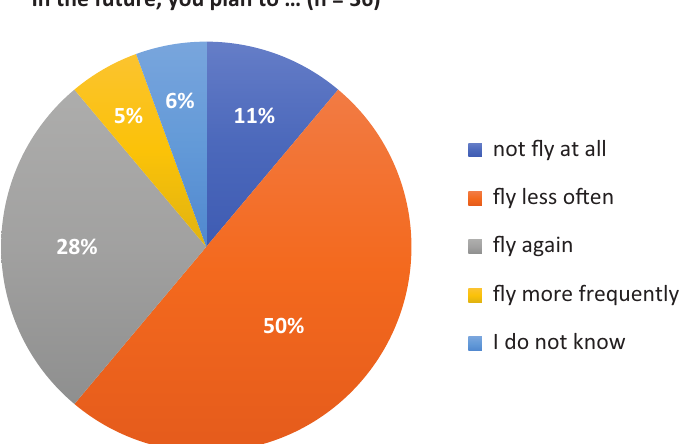
Figure 4. Expectations around future travel for the workshop